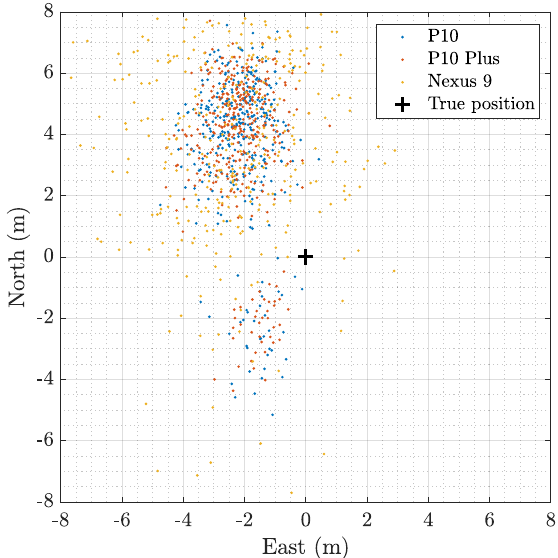
Figure 14. Clustering effect due to the presence of a low-quality signal (PRN 15) in a controlled